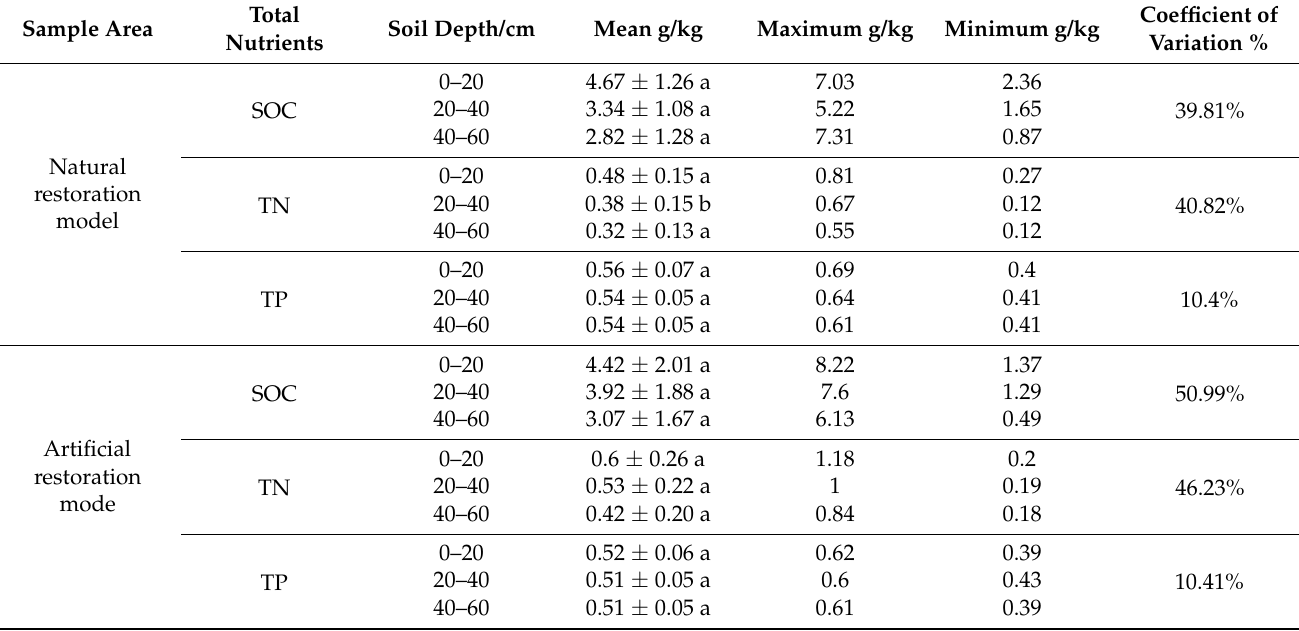
Table 1. The SOC, TN and TP content.